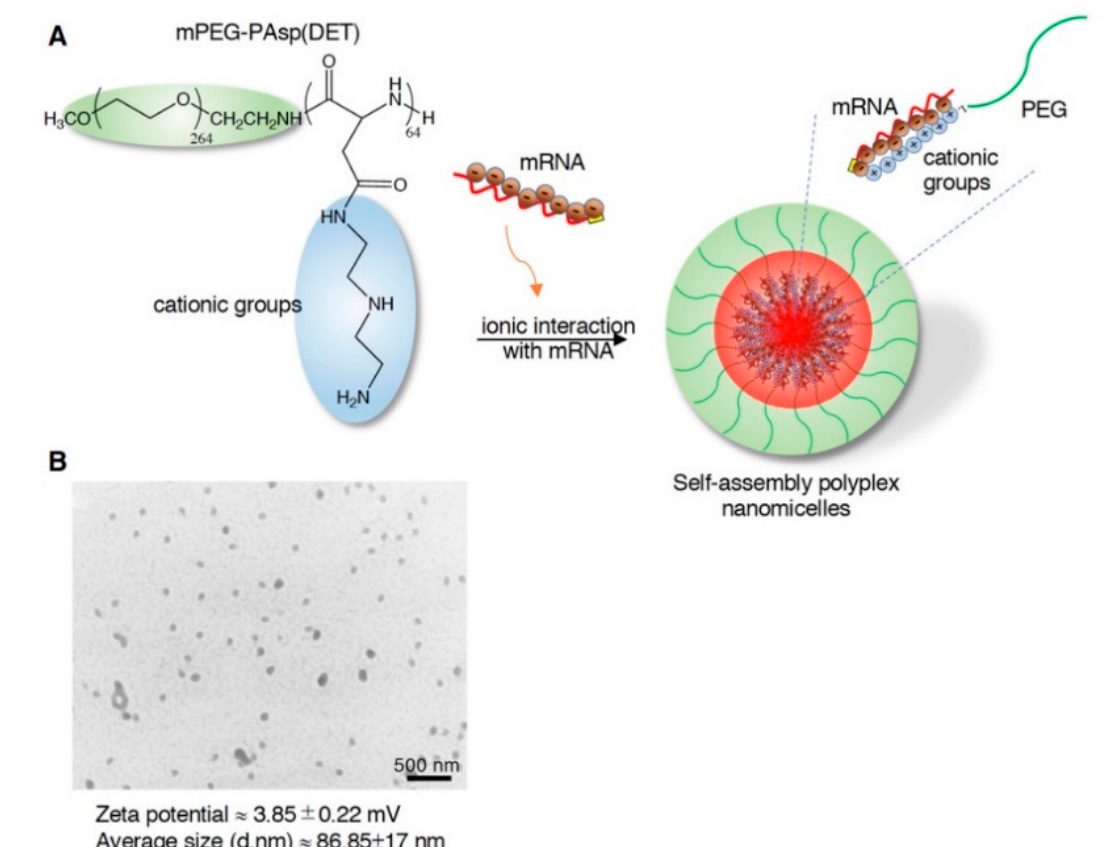
Figure 1. Preparation of mRNA-loaded PEG-PAsp(DET) polyplex nanomicelles and measurement of their physicochemical properties. ( A ) Schematic of the 12K-PEG-PAsp(DET) block copolymer electrostatically interacting with mRNA to form self-assembly polyplex nanomicelles. ( B ) Physico- chemical properties of Luc2 mRNA-loaded self-assembly polyplex nanomicelles obtained through DLS measurement.